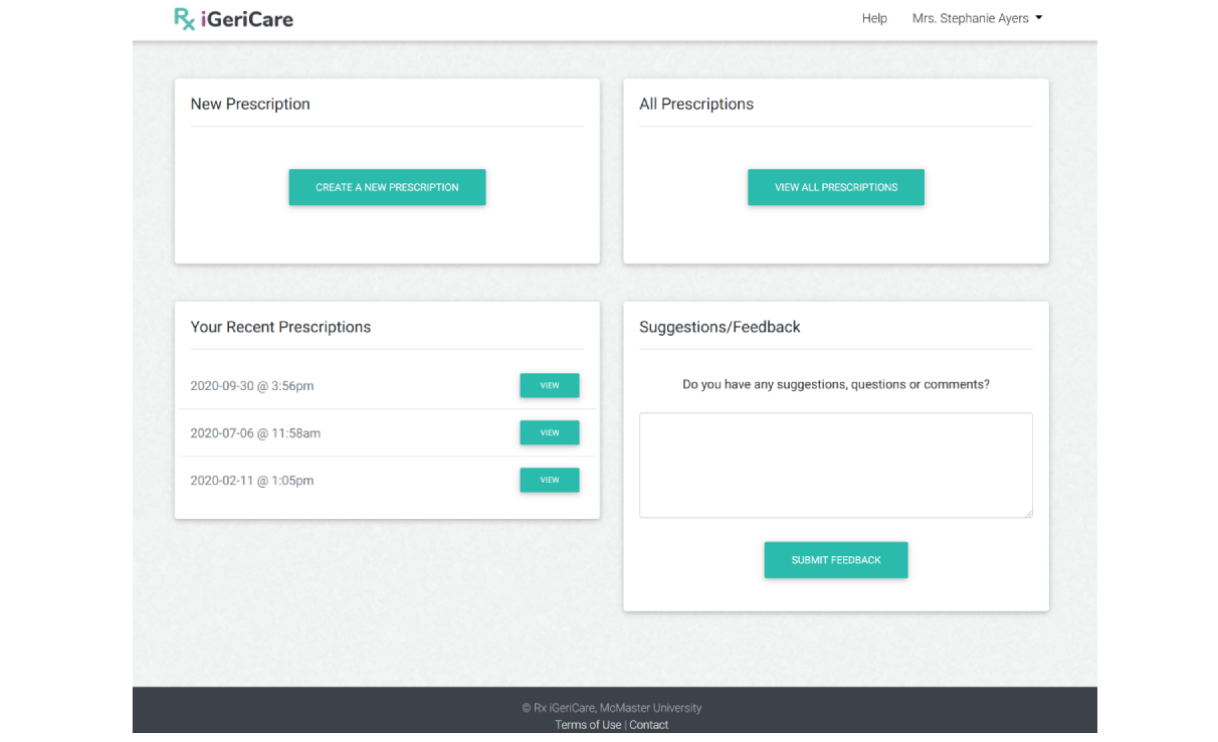
Figure 1. Education prescription application dashboard screen.